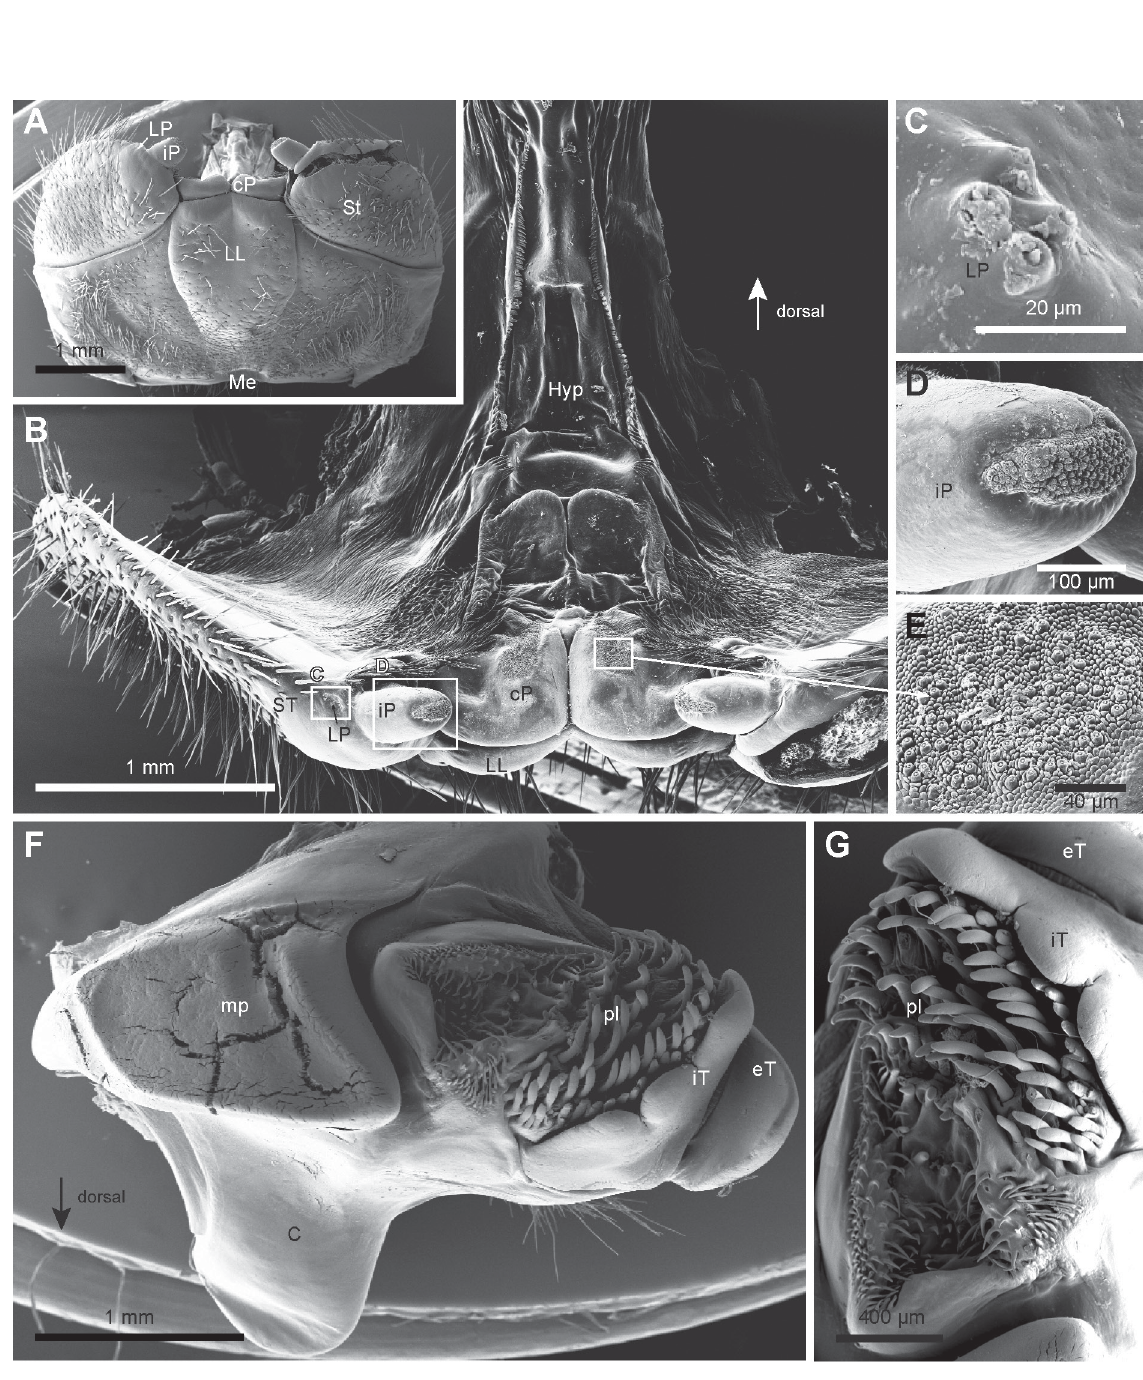
Fig. 3. Sphaeromimus kalambatritra sp. nov., SEM of mouthparts, ♂, holotype ( CASENT 9068297- A). A . Gnathochilarium overview, ventral. B . Gnathochilarium overview, frontodorsal. C . Lateral palpus, detail. D . Inner palpus, detail. E . Central pad, detail. F . Right mandible, overview. G . Pectinate lamellae, detail. Abbreviations: C = condyles; cP = central pad; eT = exterior teeth; Hyp = hypopharynx; iP = inner palpus; iT = inner teeth; LL = lamella lingualis; LP = lateral palpus; Me = mentum; mp = molar plate; pl = pectinate lamellae; ST = stipes of